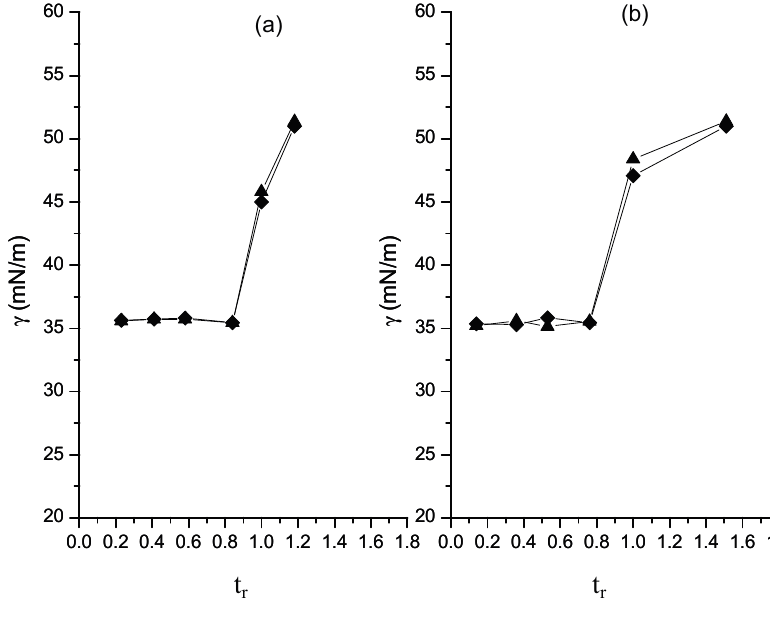
Figure 8. Surface tension of latexes as a function of relative time in polymerizations at 0.05 ( a ) and 0.15 ( b ) g/min in organic dosing rate. Runs M ( ♦ ); runs MR ( ▲